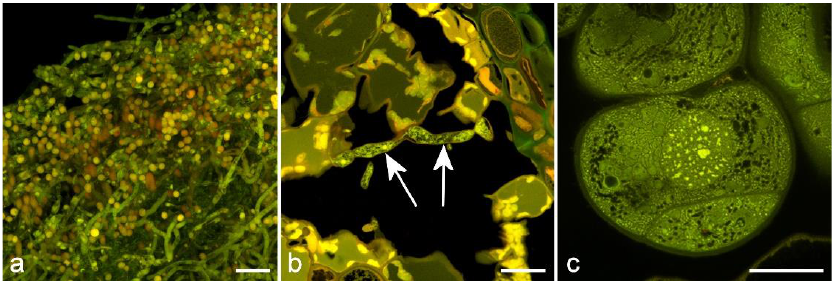
Figure 9. Glutaraldehyde-induced autofluorescence of plant tissues. ( a ) TS of Penicillium in culture showing hyphae and spores. Scale bar = 10 µm; ( b ) Pine needle infected with Phytopthora pluvialis (arrows). Scale bar = 20 µm. ( c ) Pine somatic embryo using Super-Resolution Radial Fluctuation (SRRF) microscopy [90], showing dense cytoplasm with mitochondria, endoplasmic reticulum, nucleoli, and Golgi vesicles. Scale bar = 10 µm.